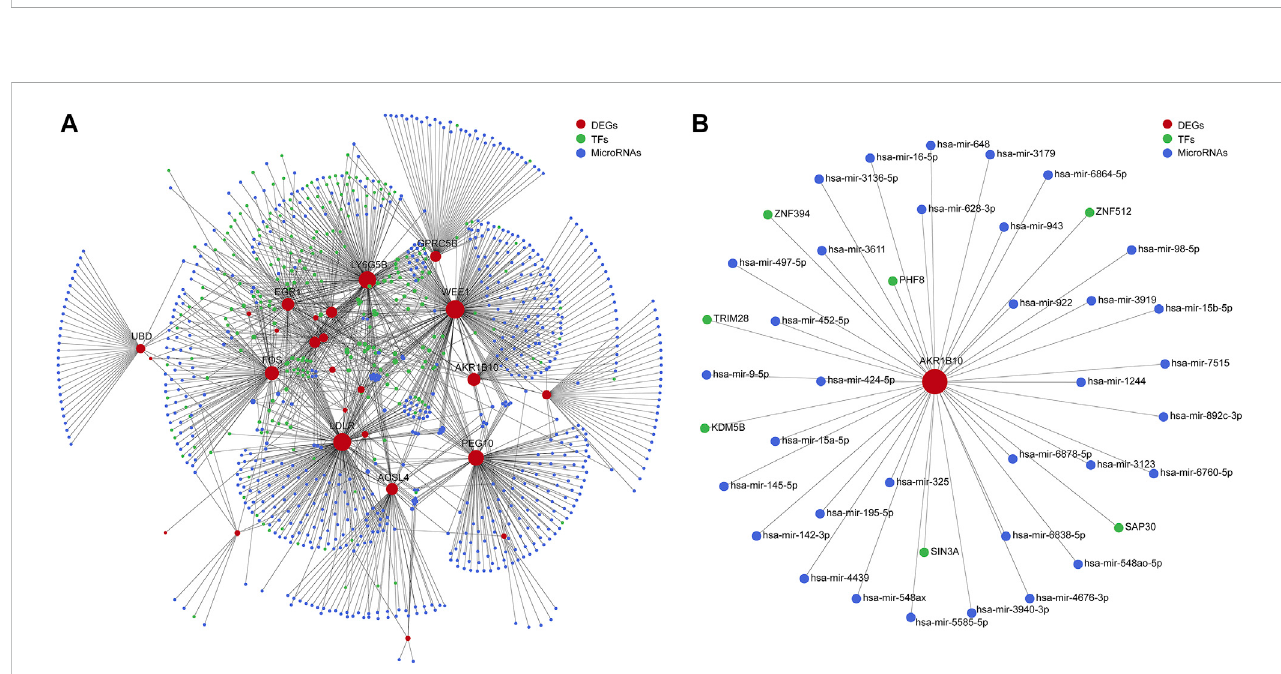
FIGURE 5 Integrative regulatory network analysis. (A) The TF – DEG – miRNA integrative regulatory network. (B) Integrative regulatory network analysis of AKR1B10. TF, transcription factor; DEGs, differentially expressed genes; miRNA, microRNA; AKR1B10, aldo-keto reductase family 1 member B10.